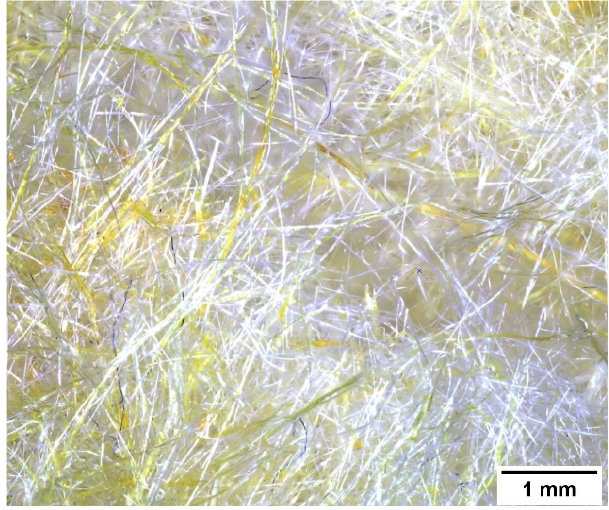
Figure 2. Histogram of particle size distribution and cumulative particle size distribution curve for the construction sand used in the investigation.